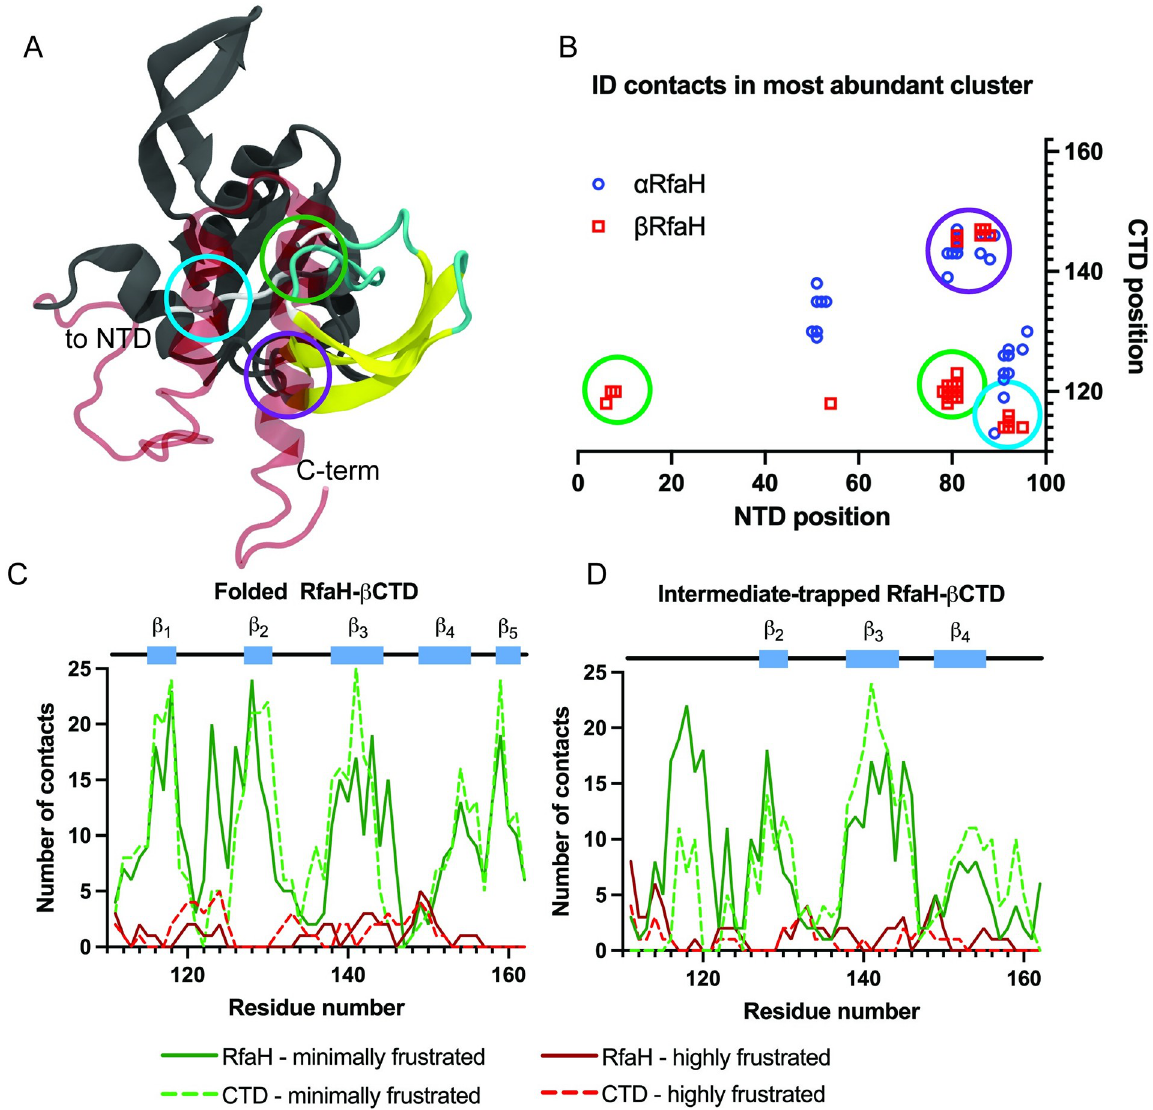
Fig 5. Contact and frustration analysis of the RfaH β -intermediate and its interaction with the NTD. (A) Superimposed structures of the α CTD (diffuse, red) and β -intermediate (yellow) on the aligned NTD (gray). The three major points of contacts are circled in different colors. (B) Contact map of the interdomain interface observed in α RfaH (blue) and in the β -intermediate (red). The number of highly (red) and minimally frustrated (green) contacts is shown for the CTD in isolation (dashed line) and in the context of full-length RfaH (solid line) for the completely folded CTD (C) or the β -intermediate